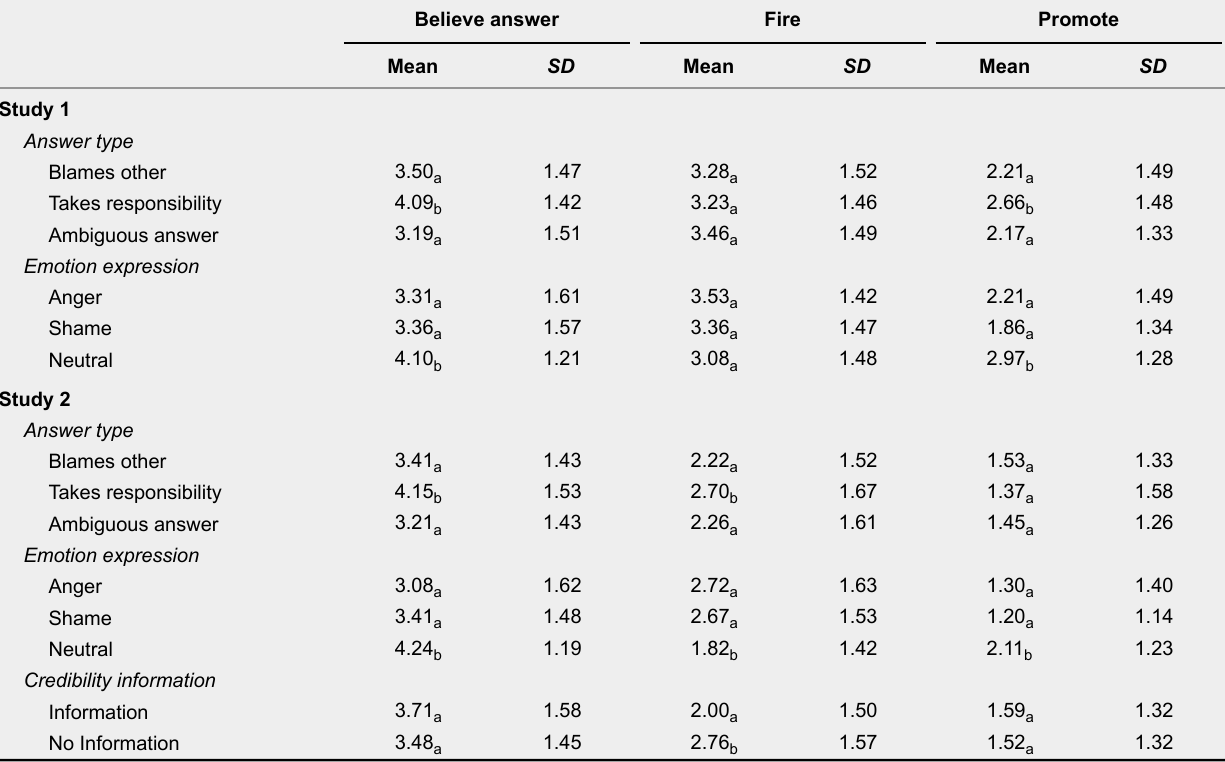
Means and Standard Deviations as a Function of Emotional Expression and Answer Type for Studies 1 and 2 PromoteFireBelieve